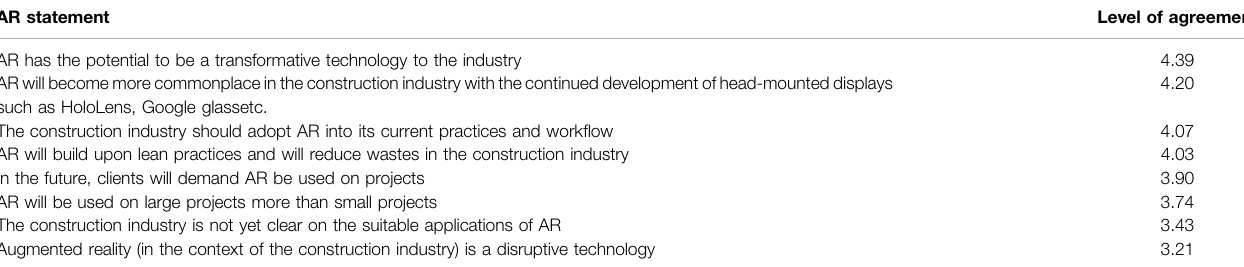
TABLE 4 | Level of agreement on AR